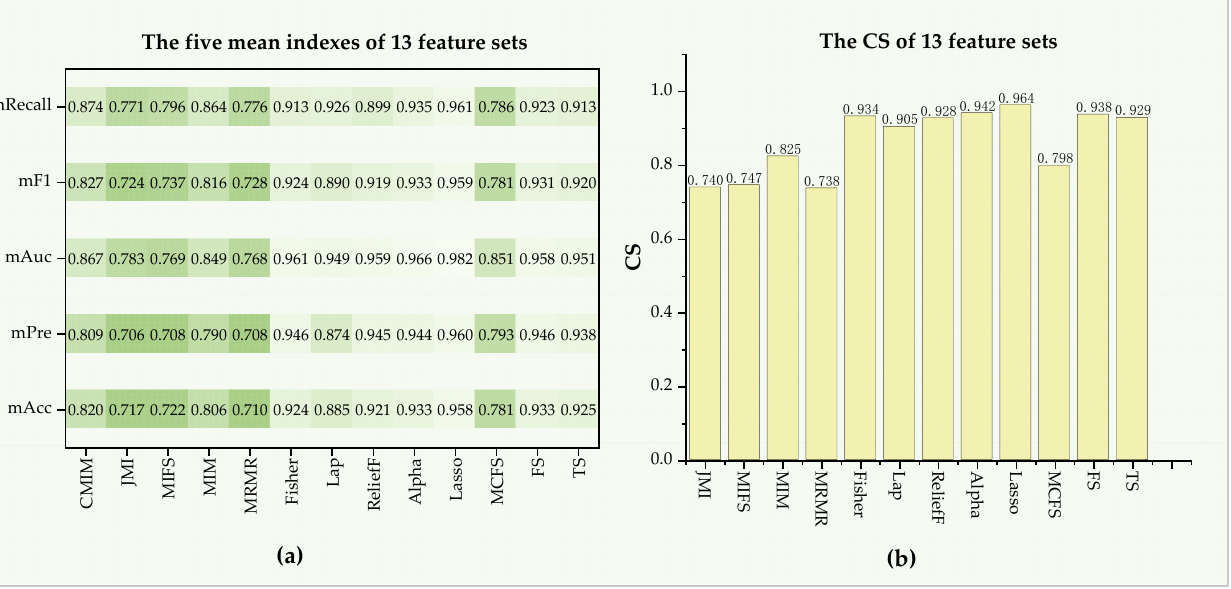
Figure 5. Performance of the 13 feature sets on the ten learning models. ( a ) Five mean indexes of 13 methods on the ten models and ( b ) CS of 13 methods.